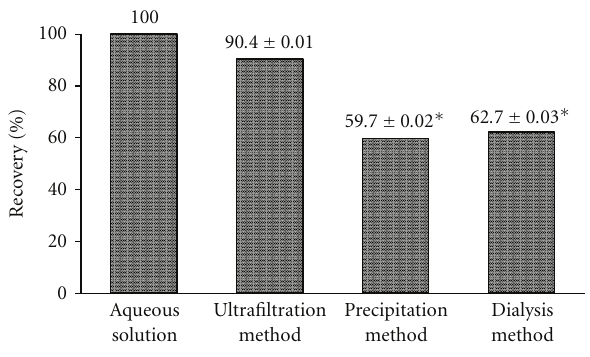
Figure 1: Recovery of APAP-Cys from spiked rat liver matrix protein dispersion by using di ff erent methods to isolate the APAP- protein adducts. Values are shown as the mean ± SD for three samples. All values were compared against those obtained for an aqueous solution of APAP-Cys, representing 100% recovery, and where ∗ P < 0 . 01 versus aqueous solution.